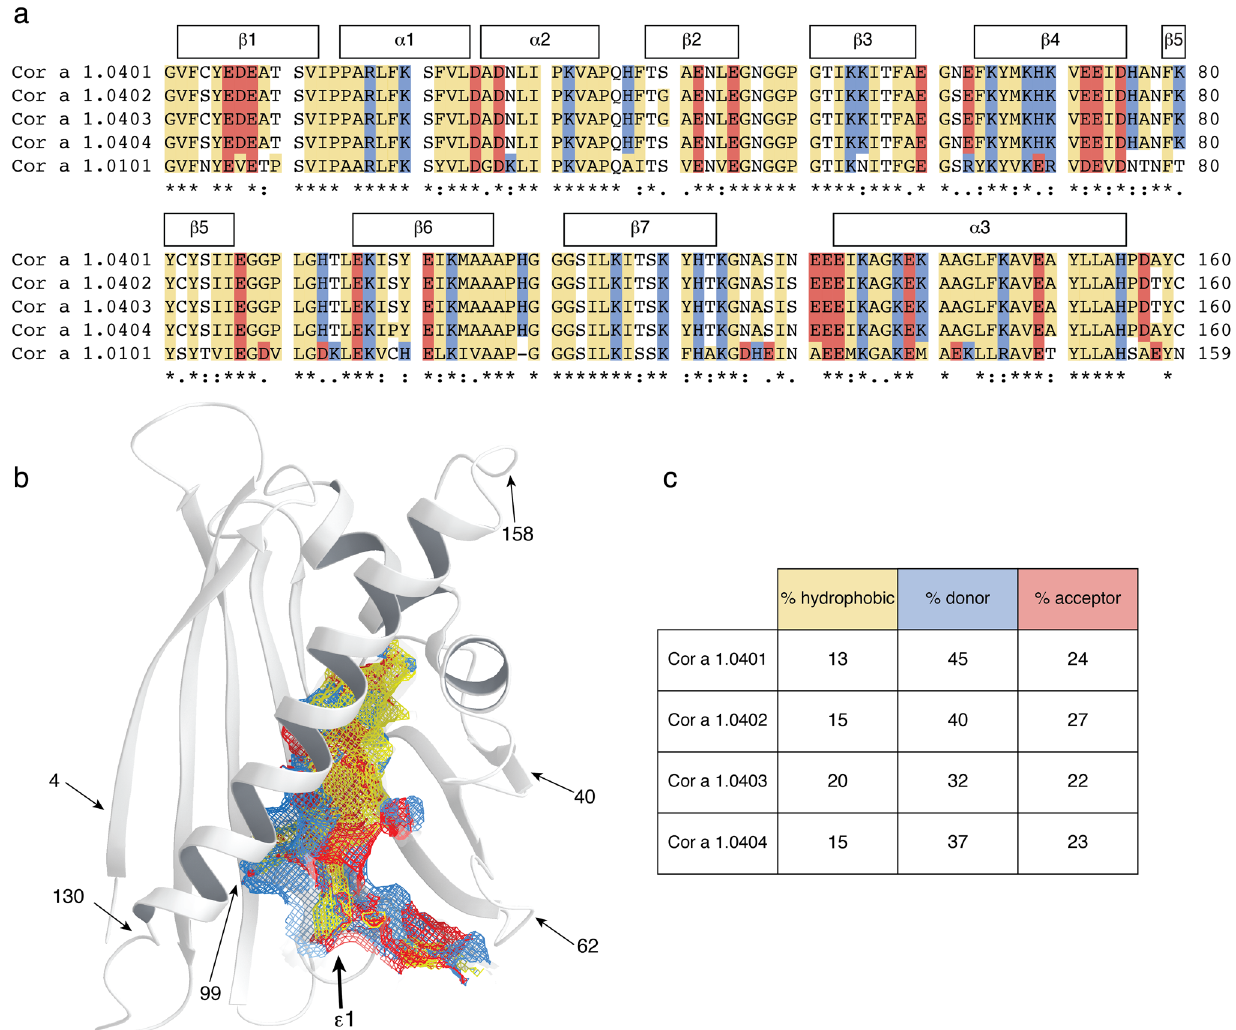
Figure 2. Amphiphilicity of the Cor a 1.04 internal cavity. ( a ) Sequence alignment of the hazelnut (Cor a 1.0401, Cor a 1.0402, Cor a 1.0403, Cor a 1.0404) and hazel pollen (Cor a 1.0101) allergens obtained with Clustal Omega 75 . Amino acid residues are labeled with asterisks (identical), colons (conserved) and dots (semiconserved). Secondary structure elements for the Cor a 1.04 isoforms are indicated on top. Hydrophobic, positively charged (donor), and negatively charged (acceptor) amino acid residues are indicated in yellow, blue and red, respectively. ( b ) Cor a 1.0401 structure (6Y3H) with the amphiphilic internal cavity colored as in ( a ), generated using Schrödinger’s Maestro Software Suite 64 . The positions of the six variable amino acid residues in the four Cor a 1.04 isoforms (4, 40, 62, 99, 130 and 158) and the cavity entrance ε1 are indicated. ( c ) Percentage of hydrophobic, proton donor, and proton acceptor interaction potential on the surface of the cavities in the four Cor a 1.04